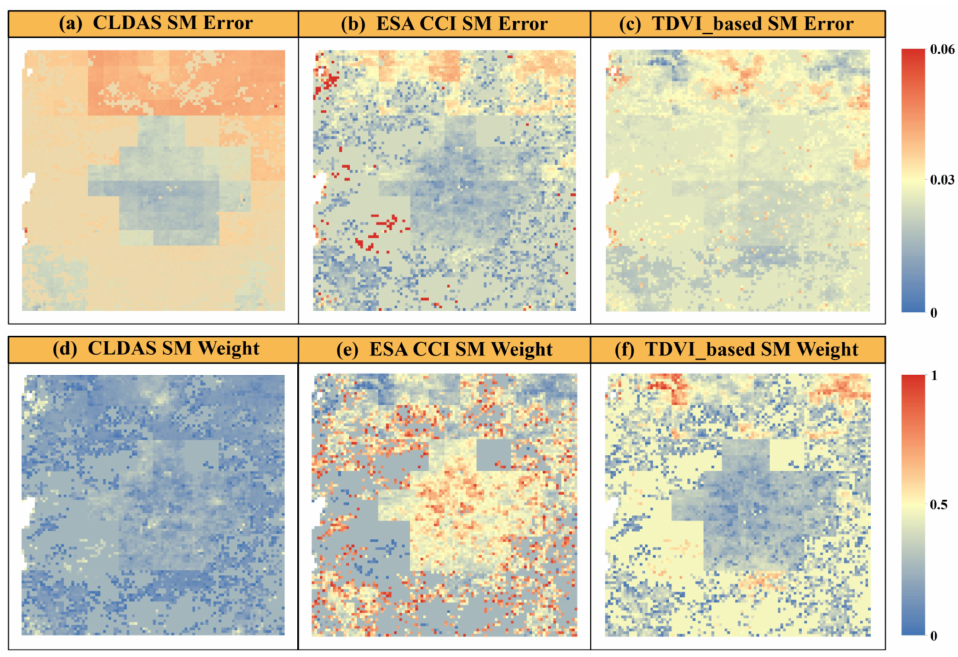
Figure 5. Relative error and weight distribution maps of CLDAS, ESA CCI, and TVDI-based SM